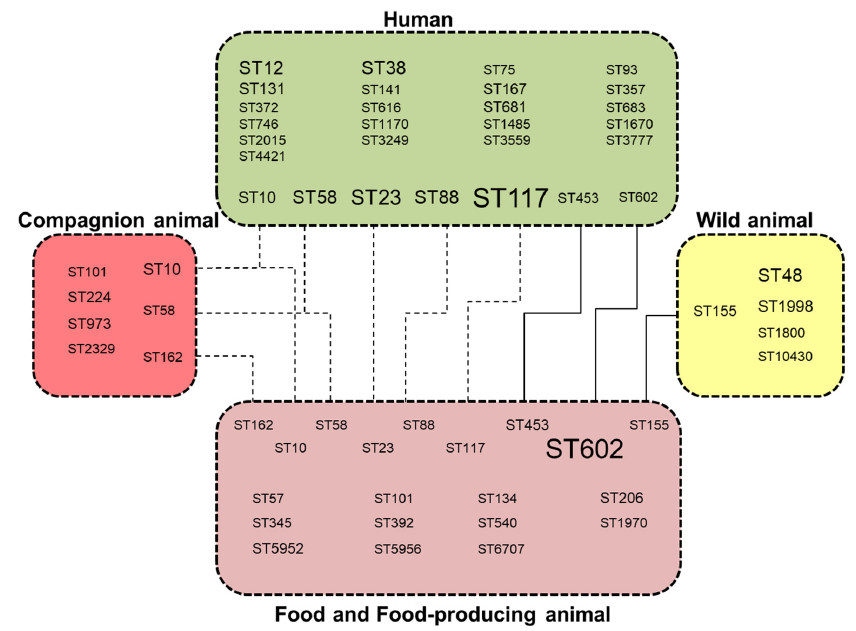
Figure 2. Distribution of E. coli ST lineages in human, human-influenced habitats and wild fauna showing deduced transmission pathways between these ecosystems. Dashed lines indicate STs shared by different habitats, and solid lines indicate closely related isolates diverging by ≤ 10 SNPs.